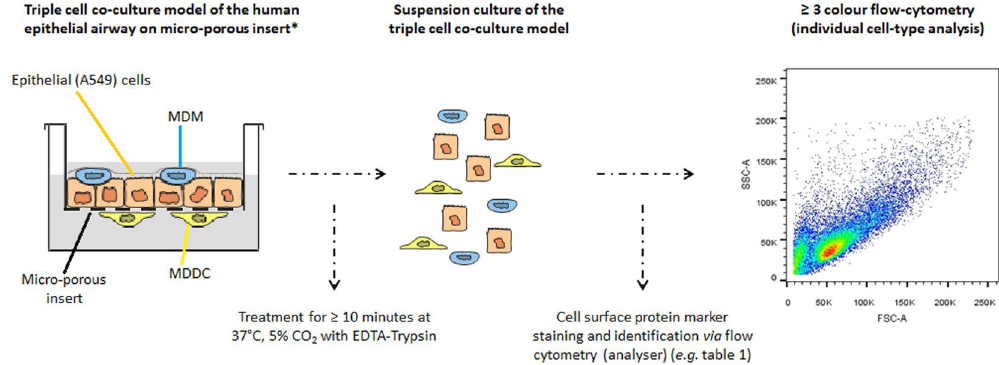
Figure 1. Schematic drawing representing the herein presented methodology. Briefly, an established triple cell co-culture model of the human lung epithelial tissue barrier (consisting of an epithelial cell layer complimented with human blood monocyte derived macrophages and dendritic cells on the apical and basolaterial sides respectively), cultured on a micro-porous membrane insert is detached to form a cell suspension using a reproducible method based upon a short Trypsin-EDTA treatment. After successful detachment, the multi-cell suspension can then be analysed via multi-colour flow cytometry (FACS) to gain a perspective upon the status of each specific cell type of the co-culture system.